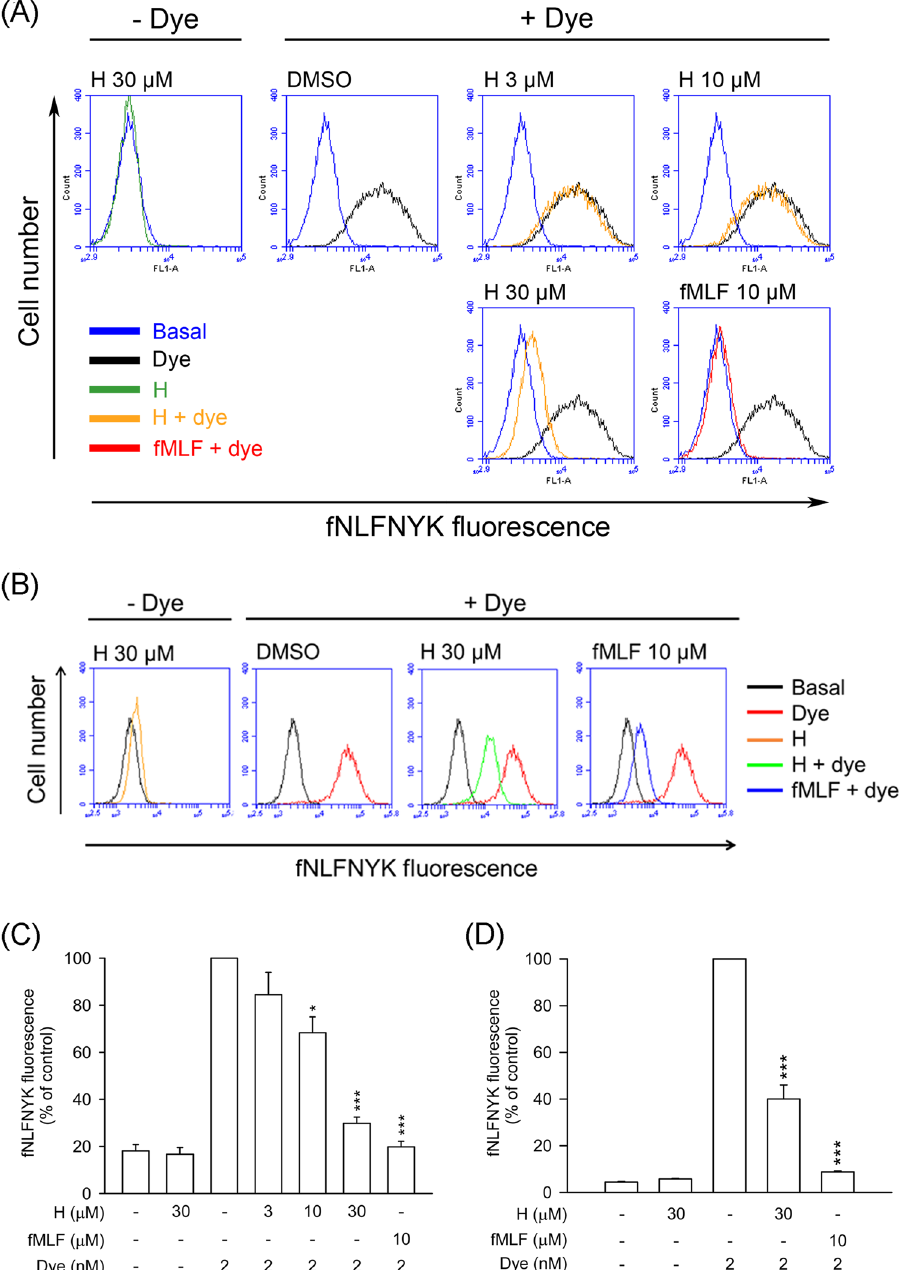
Figure 4. Honokiol blocks fNLFNYK binding to FPR1 in FPR1-expressed neutrophil-like cells. ( A ) Dibutyryl cAMP-differentiated THP-1 or ( B ) hFPR1-transfected HEK-293 cells were incubated with 0.1% DMSO (as control), honokiol (H; 3, 10, or 30 μ M), or fMLF (10 μ M) for 10 min and then labelled with fNLFNYK (2 nM) for 20 min. ( A , B ) Representative histograms showing typical fluorescence in the absence or presence of fNLFNYK with honokiol or fMLF. ( C and D ) Mean fluorescence intensities of ( A and B ) are shown as the mean ± S.E.M. ( n = 3). * P < 0.05; ** P < 0.01; *** P < 0.001 compared with fluorescent dye